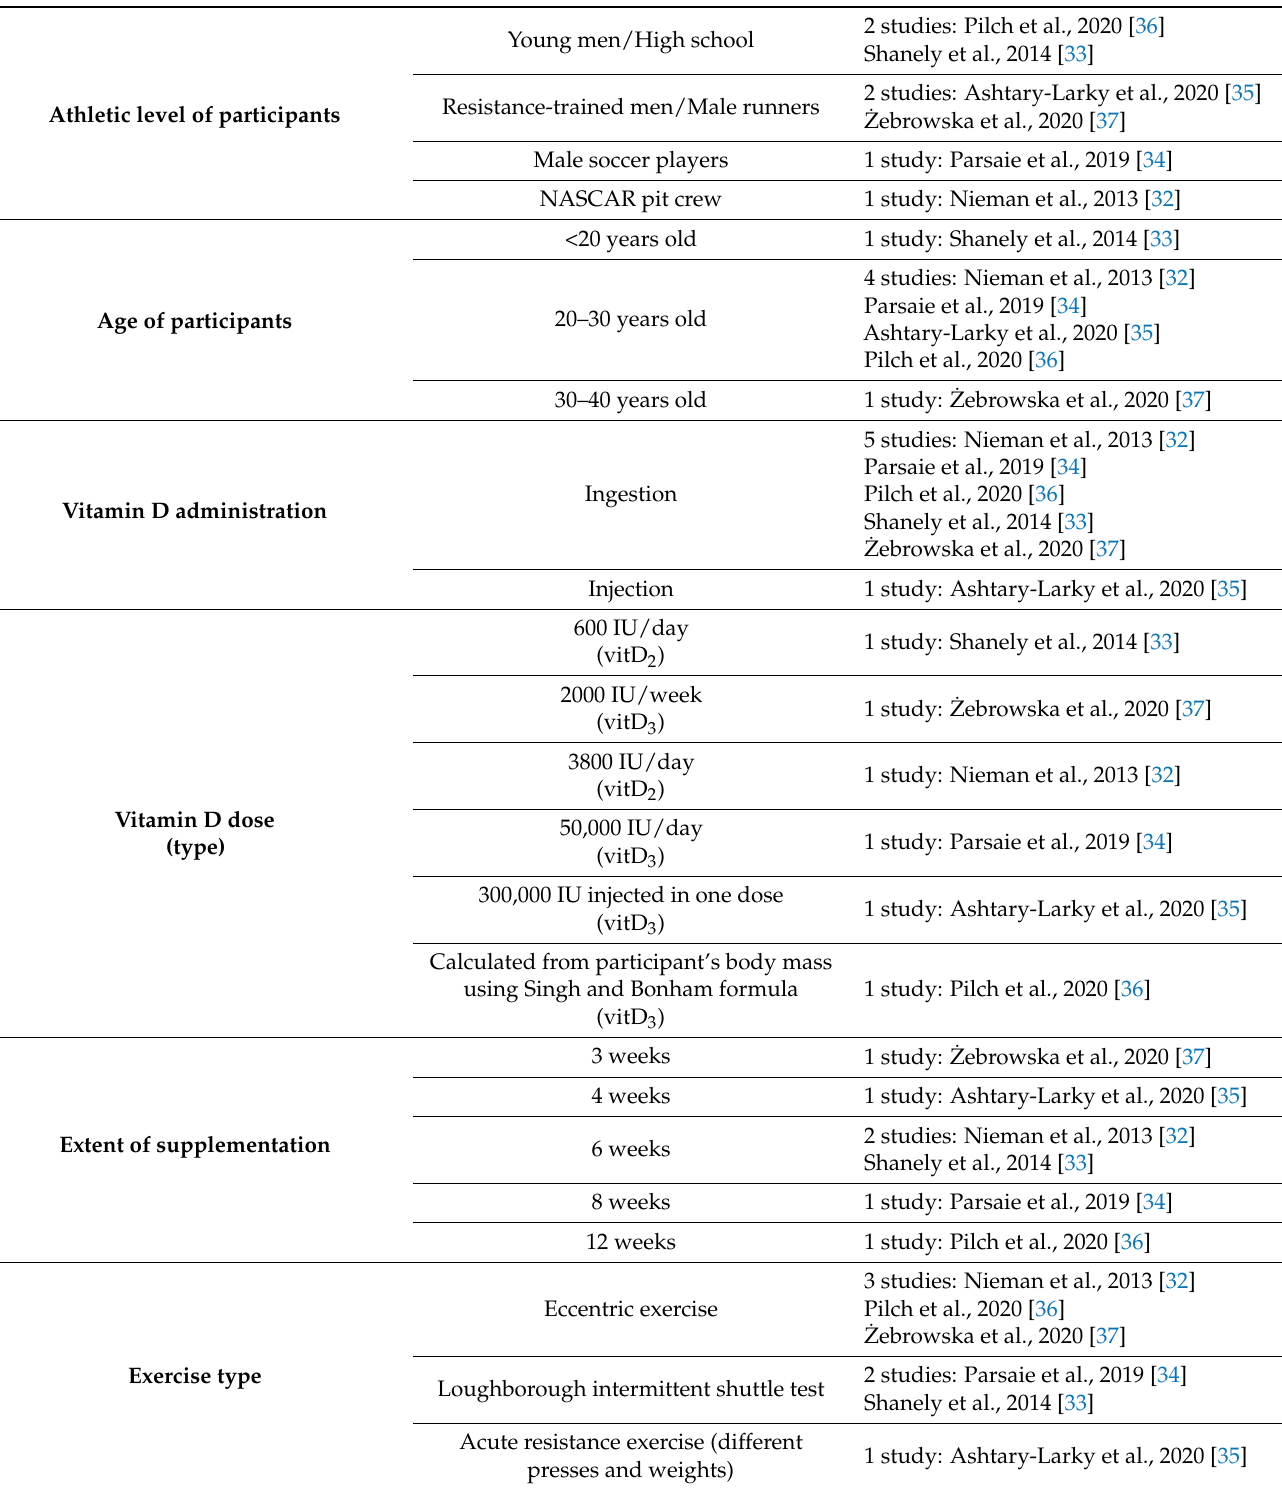
Table 2. General characteristics of the selected